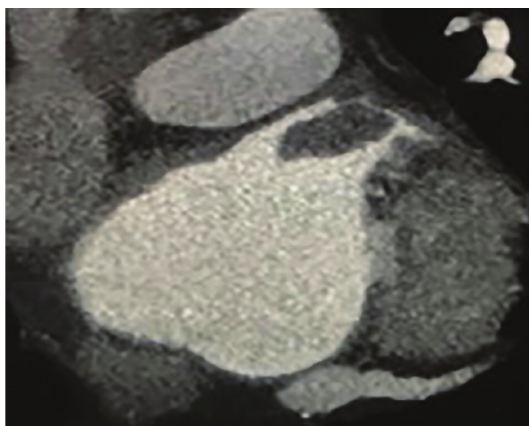
Figure 2A - LAA thrombus detected by CT